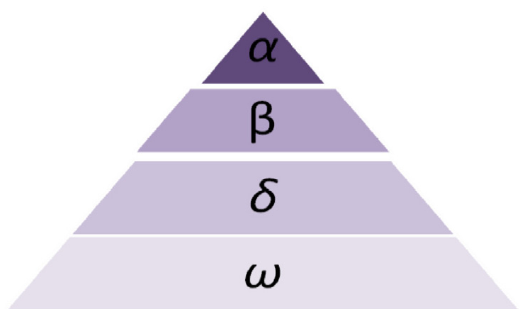
Figure 2. Social hierarchy of a pack of grey wolves [30] .